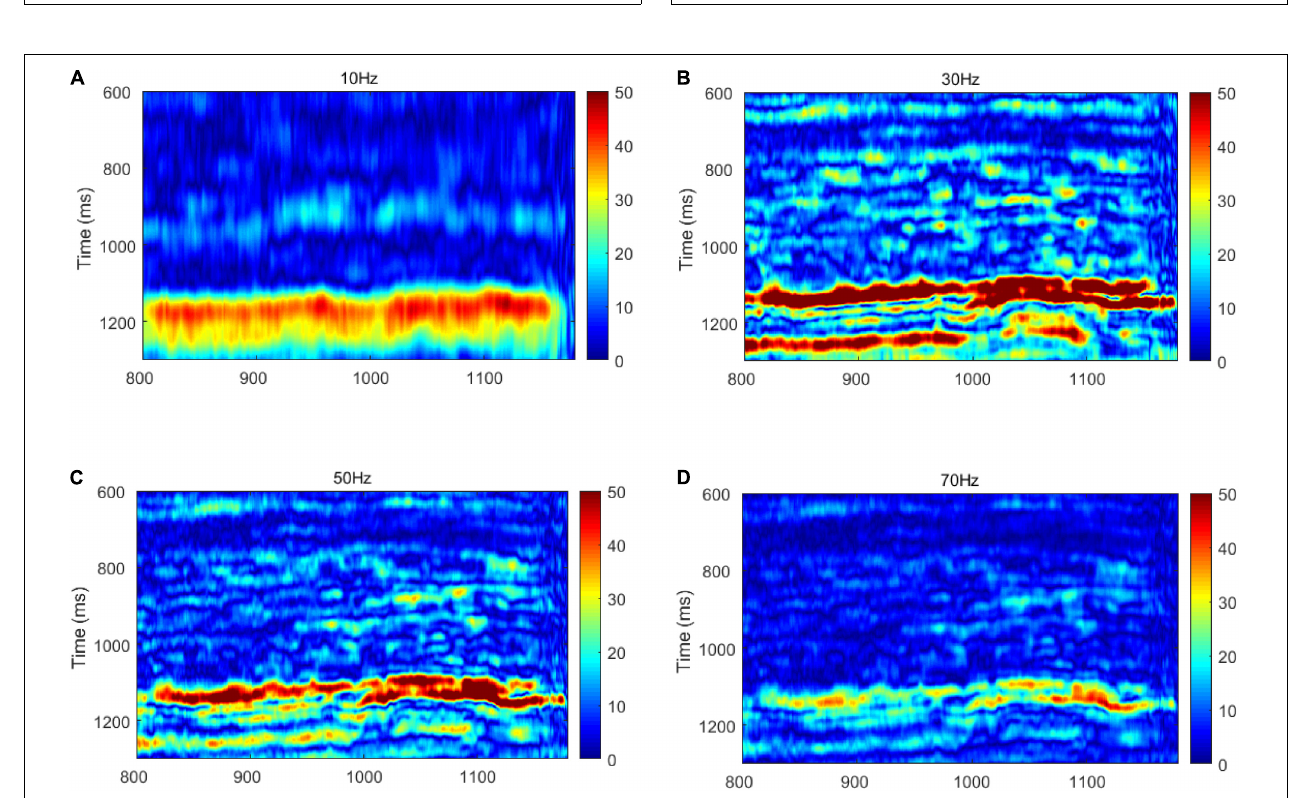
FIGURE 10 | Time-frequency analysis of the post-stack seismic profiles shown in Figure 9 . (A) 10 Hz; (B) 30 Hz; (C) 50 Hz; and (D) 70 Hz.